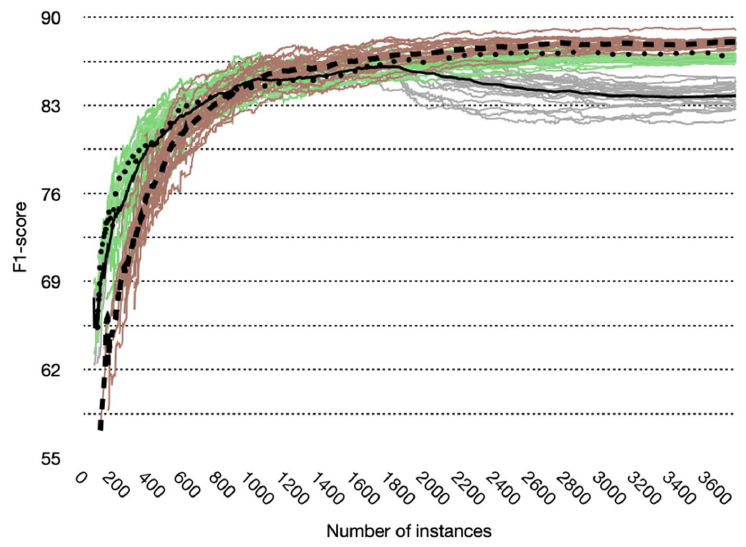
Figure 6. Learning curves for all participants and their average. NB: green lines, average on the dotted line. HT: gray lines, average on the solid line. KNN: red lines, average in broken line.